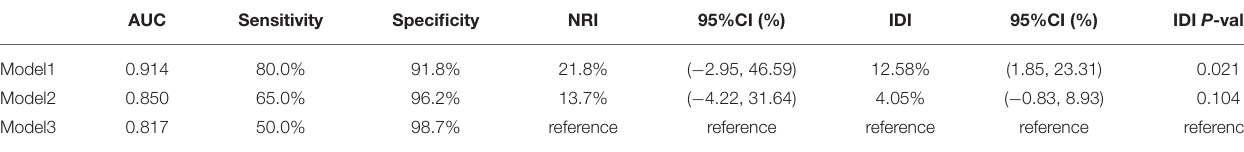
TABLE 5 | Comparison of three model capabilities.